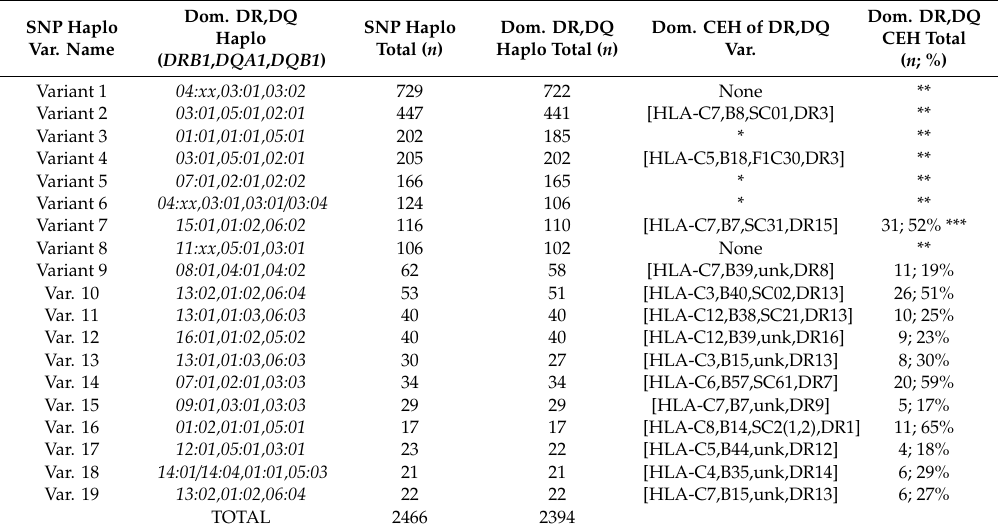
Table 5. Dominant MHC CEHs in major 27-SNP edited haplotypes of the DR,DQ region 1